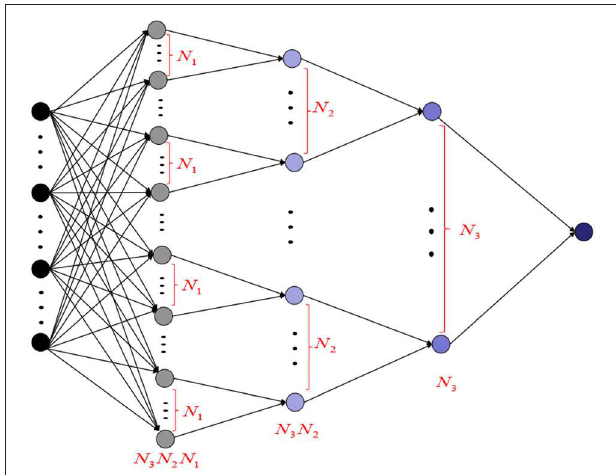
FIGURE 5 | Size of tree in deep